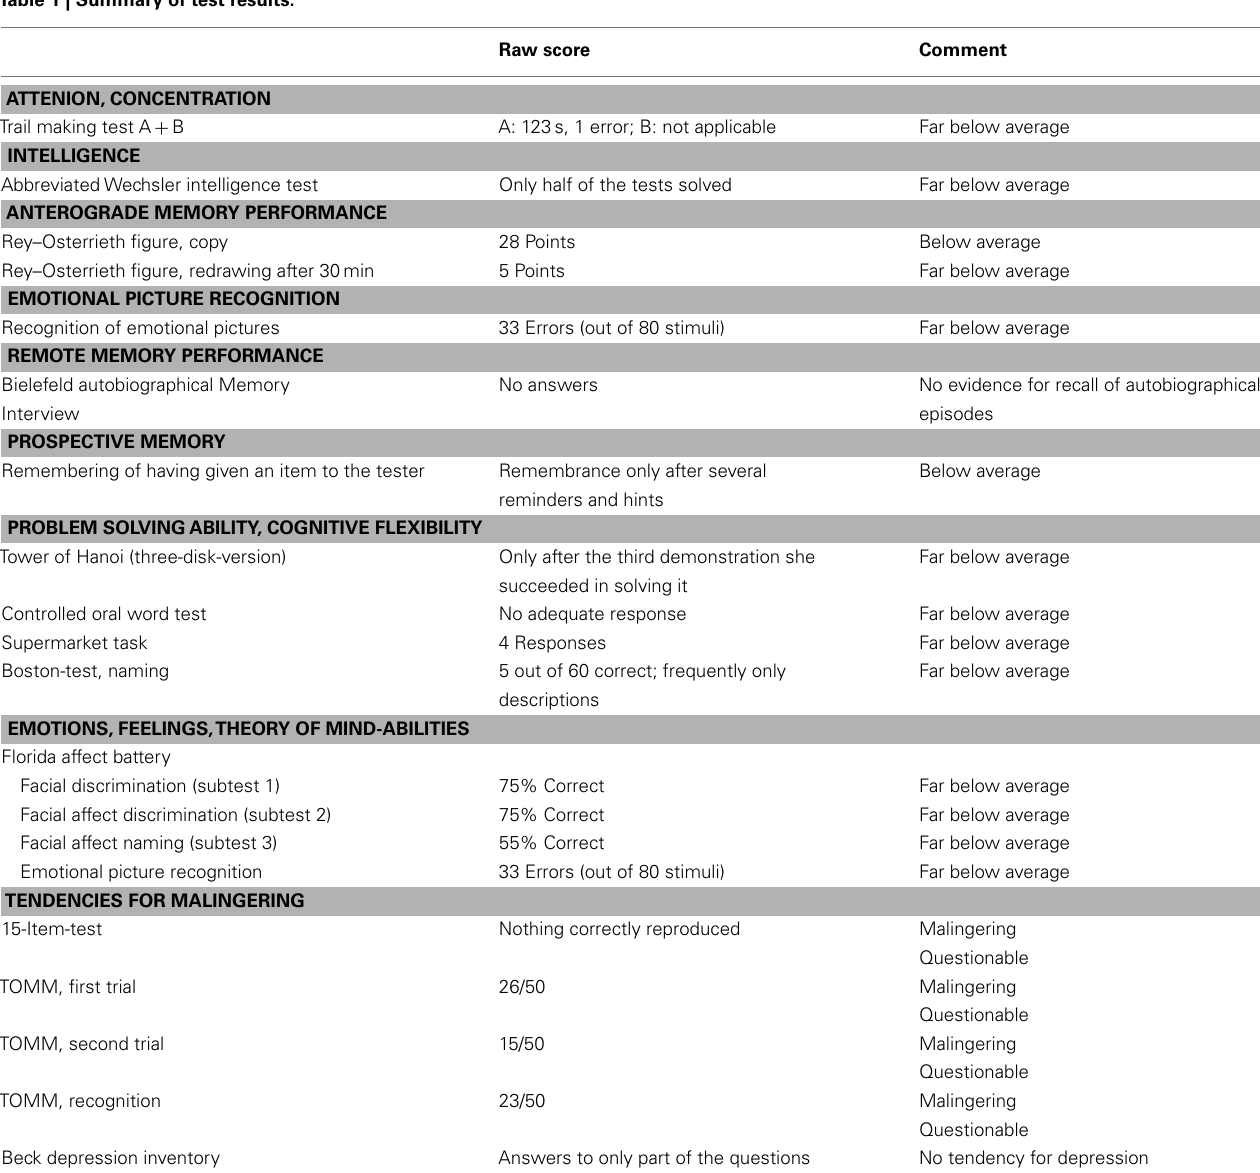
Table 1 | Summary of test